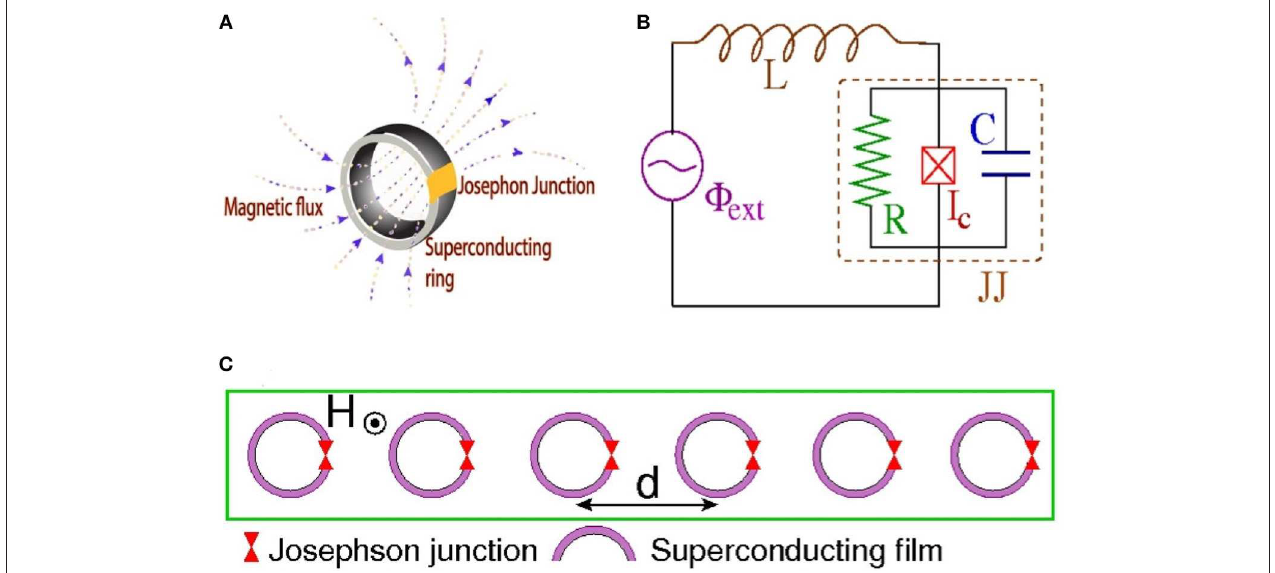
FIGURE 1 | (A) Schematic of a SQUID (superconducting quantum interference device) in a magnetic field. (B) Equivalent electrical circuit. (C) Schematic top view of a one-dimensional periodic array of SQUIDs in a magnetic field H .